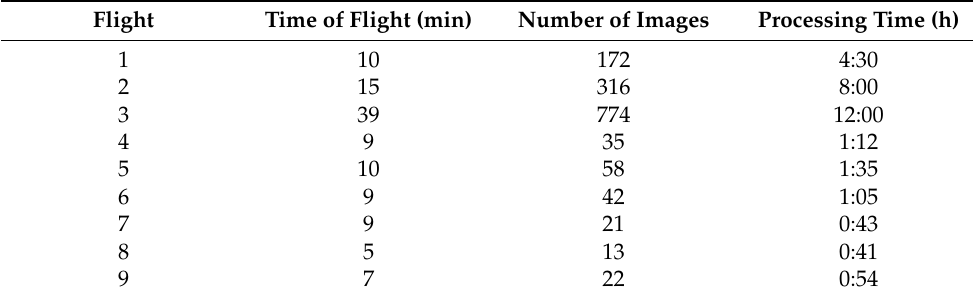
12 of 21 Table 5. Time of flight, number of images, and processing time of each flight. Flight